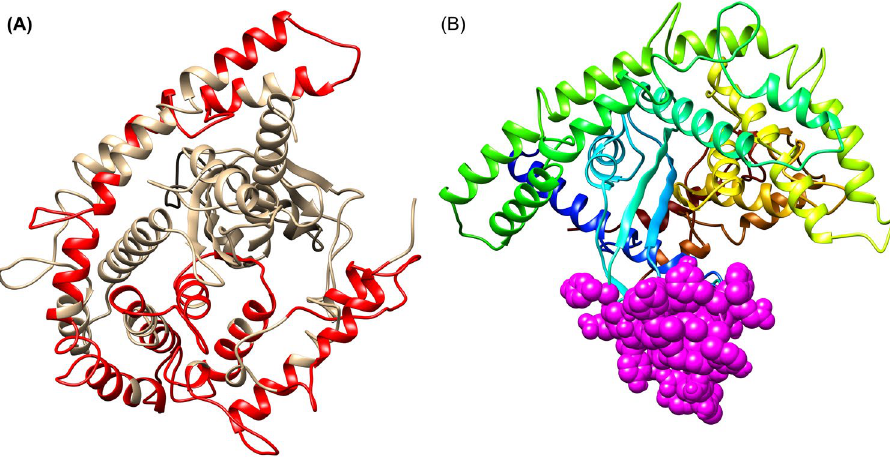
Figure 1. Humoral epitope predictions for subunit vaccine. ( A ) Showing the linear B-cell epitopes (red color) among the 3D structure of final vaccine construct (golden color). ( B ) Conformational B-cell epitopes (magenta color) showing the sequence subunits composed of antigenic epitopes that will come in direct contact with immune